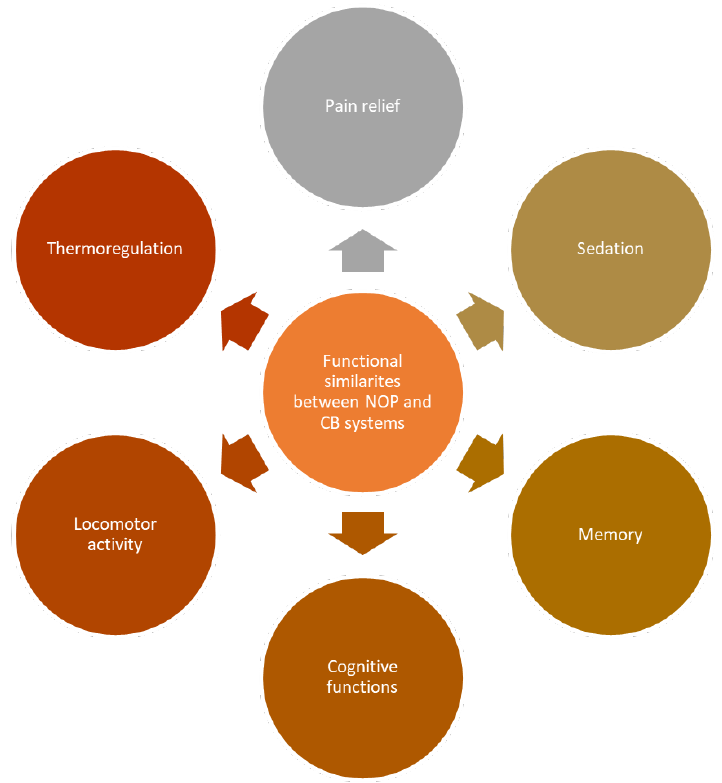
Figure 1. Functional similarities between NOP and CB systems.